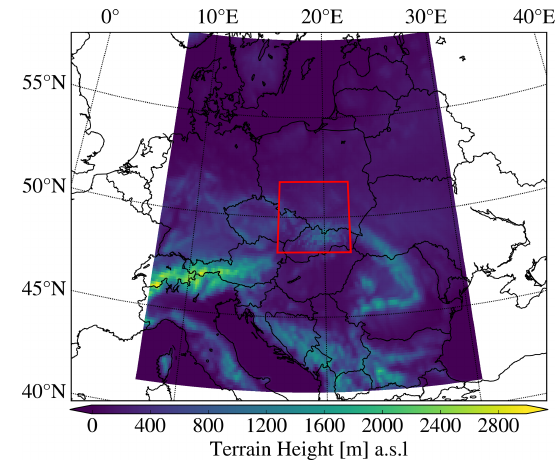
Figure 3. Overview of the two WRF domains over central Europe. The first larger domain (colored shape) has a spatial resolution of ∼ 15km. The inner domain (red rectangle) has a spatial resolution of ∼ 3km and is focused on the USCB. The Tatra mountain ridge (with elevations > 2000ma.s.l.) in the southern part of the second domain along the border towards Slovakia is fully enclosed by the inner